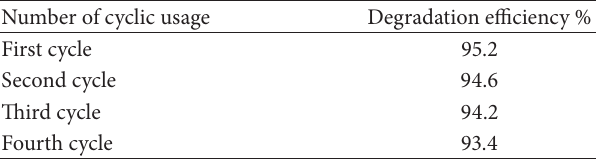
Figure 8: Effect of initial furfural concentration on the photocat- alytic degradation of furfural. TiO 2 /GAC composite dosage: 2.5 g/L, irradiation time: 80min, and initial pH: 10. Table 2: The cyclic photocatalytic performance of TiO 2 /GAC composite for furfural degradation with furfural concentration = 500 mg/L, initial pH = 10, photocatalyst dosage = 2.5 g/L, and irradiation time of 80min.